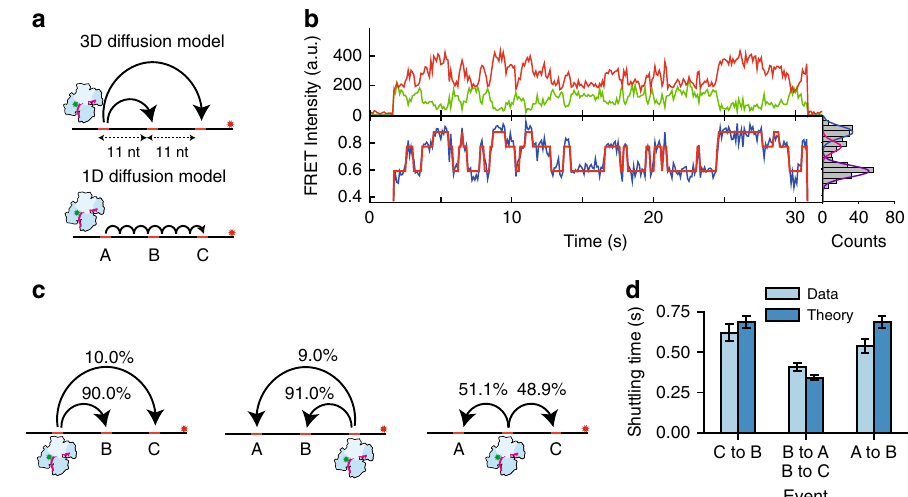
Fig. 4 Cb Ago undergoes short range diffusion through correlated steps. a Models for target translocation at short range. In the 3D diffusion model, target dissociation occurs from A followed by random 3D diffusion through solution. In effect, the neighboring two targets (B and C) will compete for binding. In the lateral diffusion model, the Cb Ago complex will have to bypass the adjacent target B before binding to target C. b Representative FRET trace showing the shuttling behavior between three targets. Top: donor (green) and acceptor (red) intensities. Bottom: FRET trace (blue) and HMM assigned states (red). Right: The fi tted states from this data trace with dark blue: state C, pink: state B and purple state A. c Transition probabilities from state A to B,C (left), from state C to A and B (middle) and from state B to A or C (right). d Experimental values of the shuttling time of the three target construct were compared against the parameter-free theoretical model that only uses the k esc = 15.8 s − 1 from Fig. 3. Error bars indicate the 95% con fi dence interval acquired from 10 5 bootstraps (see Supplementary Information). Source data are provided as a Source Data fi